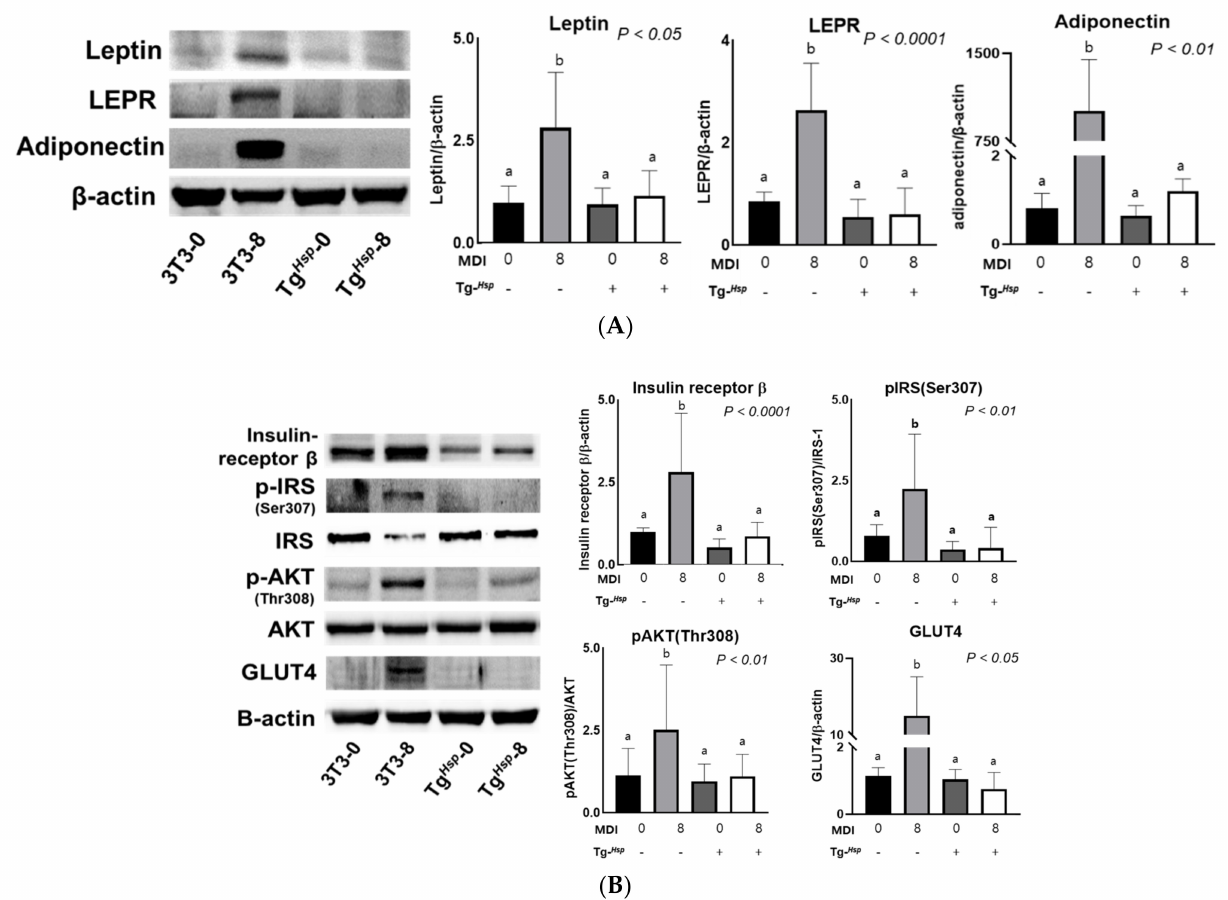
Figure 3. Expression of leptin, LEPR, and adiponectin in 3T3 − L1 and Tg Hsp cells ( A ). Tg Hsp inhibits insulin signaling in 3T3 − L1 cells ( B ). Protein levels of adipokines and insulin signals were analyzed by Western blotting. Data are presented as means ± SDs of at least three replicates. Means with different superscripts are significantly different at p < 0.05 by Duncan’s multiple range